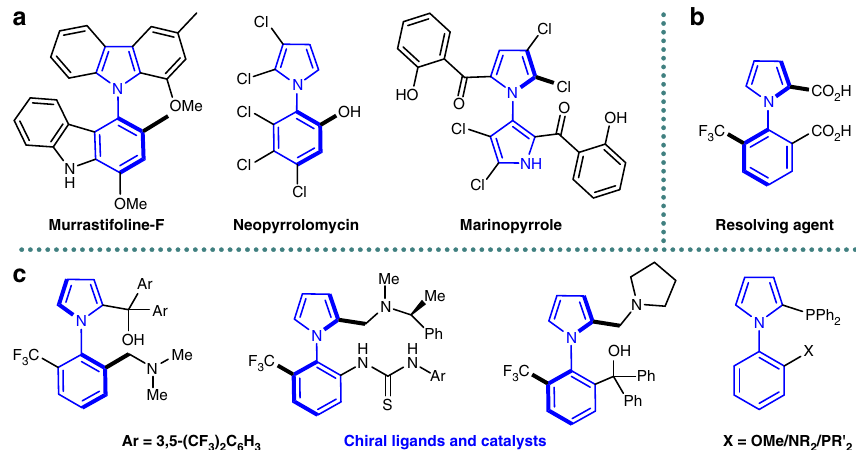
Fig. 1 Representative molecules containing axially chiral arylpyrrole frameworks. a Bioactive natural products. b Resolving agent. c Chiral ligands and